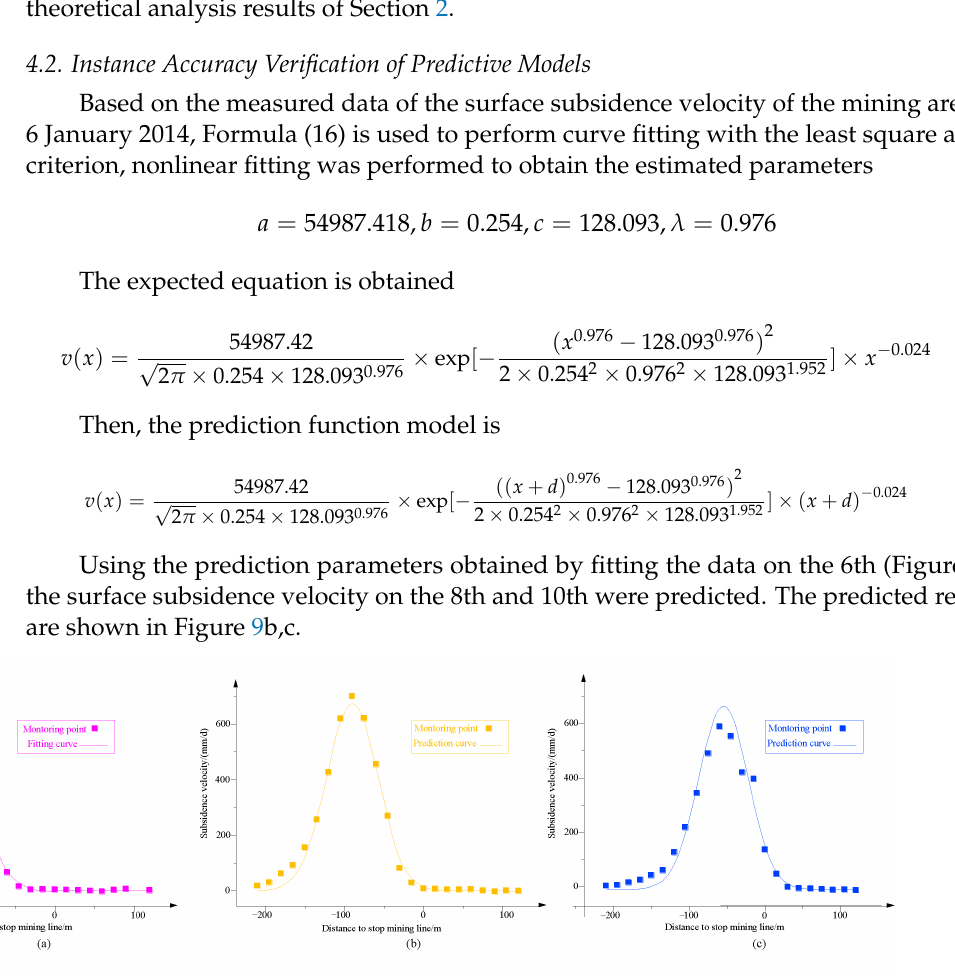
Figure 9. Fitting curve and prediction curve. ( a ) 6 January 2014, ( b ) 8 January 2014, ( c ) 10 January